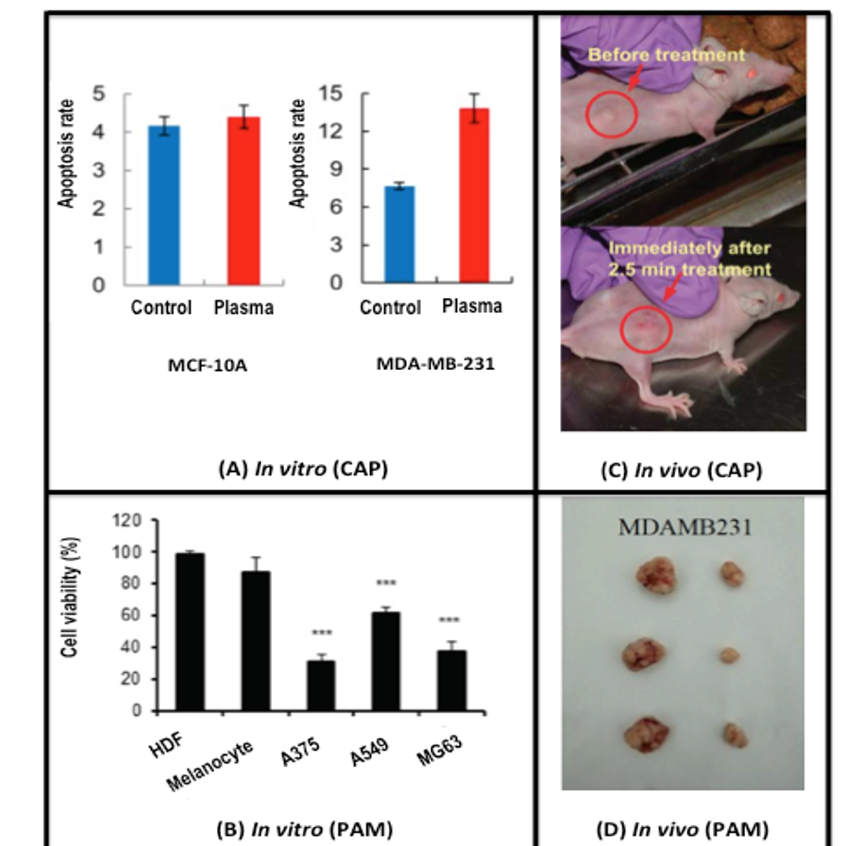
Figure 1. CAP-induced selective cancer cell death. ( A ) in vitro evidence showing the selectivity of CAP on cancer cells. The apoptosis rate of cancer cells (MDA-MB-231) increases 1.75-fold after CAP treatment, while that of non-transformed cells (MCF-10A) does not significantly change. Reproduced with permission [23]. Under the terms of the Creative Commons Attribution License. ( B ) in vitro evidence showing the selectivity of PAM on cancer cells. The cell viabilities after PAM treatment significantly decrease in cancer cells (A375, A549, MG63), but do not change with statistical significance in non-transformed cells (HDFs, melanocytes). Reproduced with permission [49]. Under the terms of the Creative Commons Attribution License. ( C ) An in vivo subcutaneous tumor model showing the efficacy of CAP in cancer shrinkage. The tumor of about 5 mm in diameter shrinks without observing any damage to the normal tissue immediately after 2.5 min single time CAP treatment. Reproduced with permission [22]. Under the terms of the Creative Commons Attribution-Noncommercial-Share Alike 3.0 Unported License. ( D ) An in vivo orthotopic tumor model showing the efficacy of PAM in cancer shrinkage. The tumor size was considerably reduced after injecting PAM into MDA-MB-231 cell-inoculated tumors of mice. The measurement was conducted at the 29th day after PAM injection. Reproduced with permission [50]. Copyright c (cid:13) 2018, Elsevier. PAM is short for ‘plasma-activated medium’. By listing evidence of both CAP and PAM in achieving therapeutic efficacy against cancer cells both in vitro and in vivo, we can see that it is indeed the RONS that play the most critical role in plasma cancer therapy as PAM lacks other effects of CAP such as fields, UV, etc. *** means p < 0.05 from student T